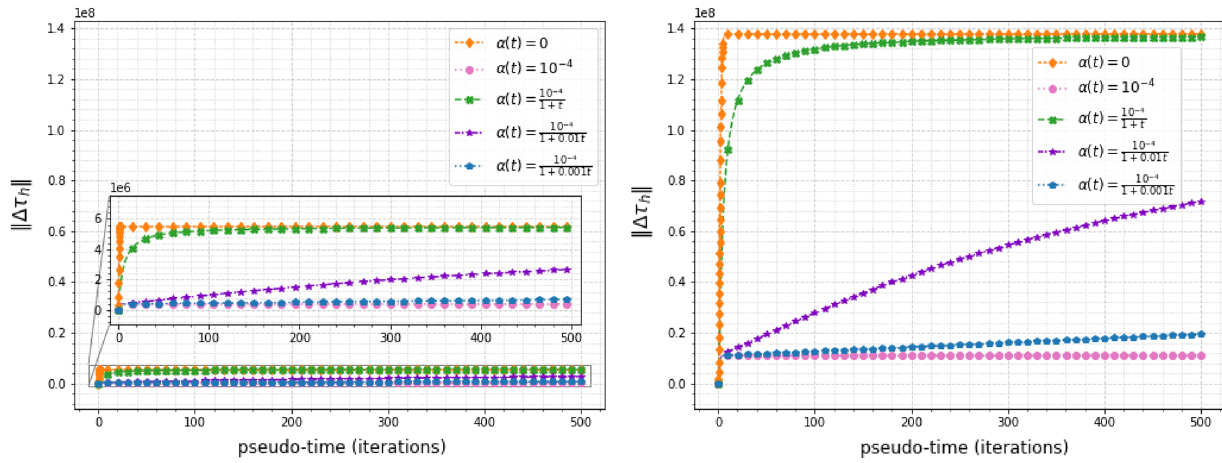
Δ 𝝉 n for different values of parameter 𝜀 of diffusion coefficient 𝛼 ( t ) = 10 − 4 ‖ ‖